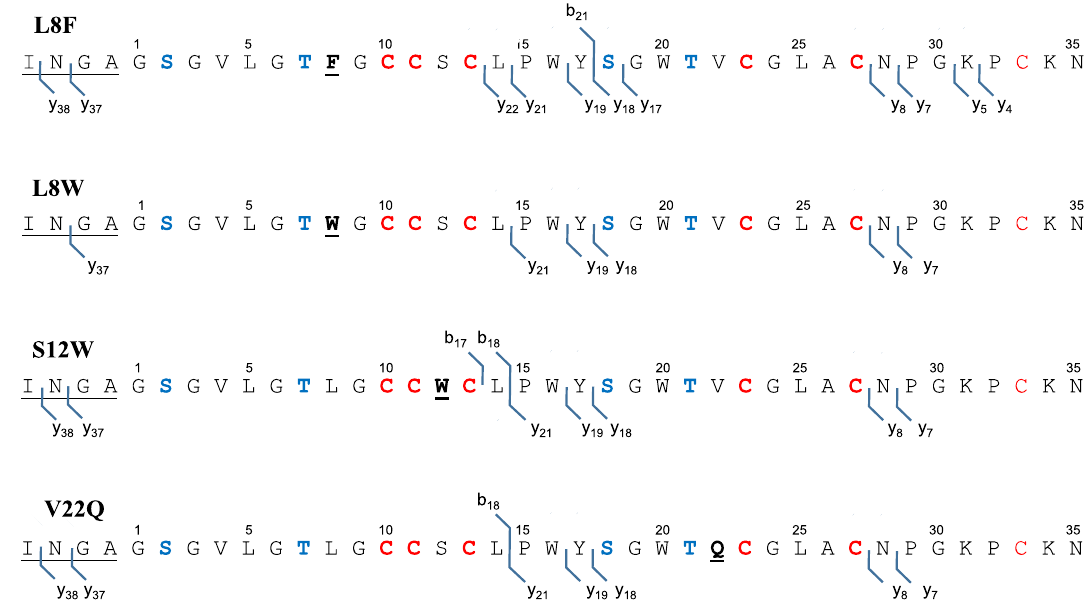
Fig. 8 Tandem MS fragmentation pattern of alkylated Rosα variants confirms the similar ring topology in all the variants as that of wild-type Rosα, published earlier (Singh et al. 2020). Underlined regions correspond to leader sequence overhang that remained attached after endoproteinase GluC proteolytic digestion